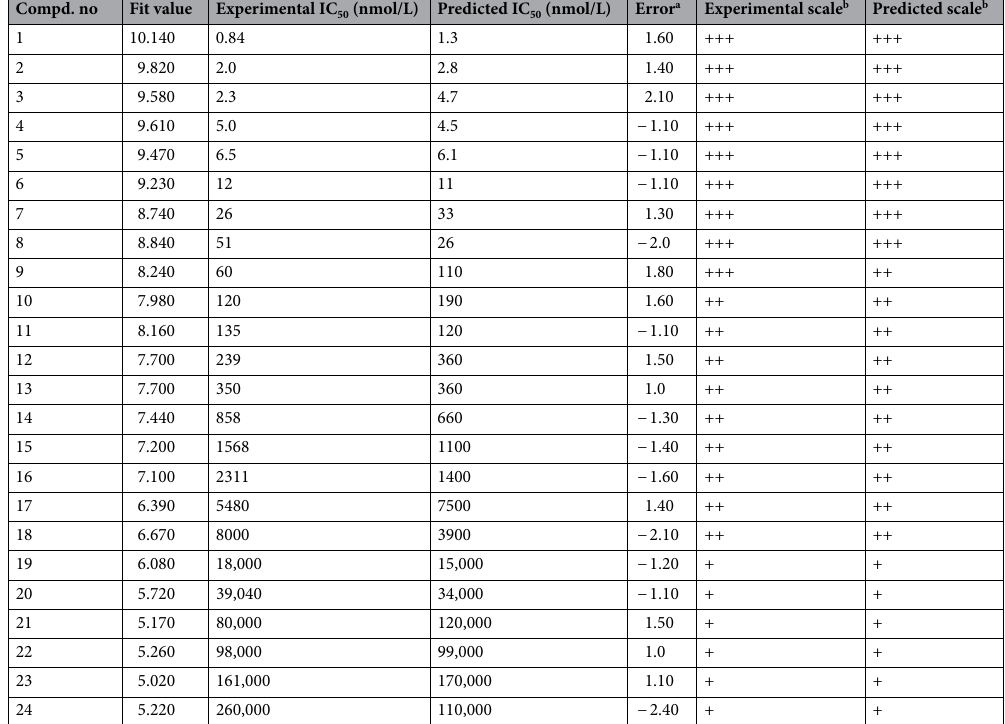
Table 2. The experimental and predicted activity of training set compounds based on Hypo 1. a Values in the error column represent the ratio of the estimated activity (Pred IC 50 ) to the experimental activity (Exp IC 50 ) or its negative inverse if the ratio is < 1. b Activity scale: IC 50 < 100 nmol/L = +++ (active), 100 nmol/L ≤ IC